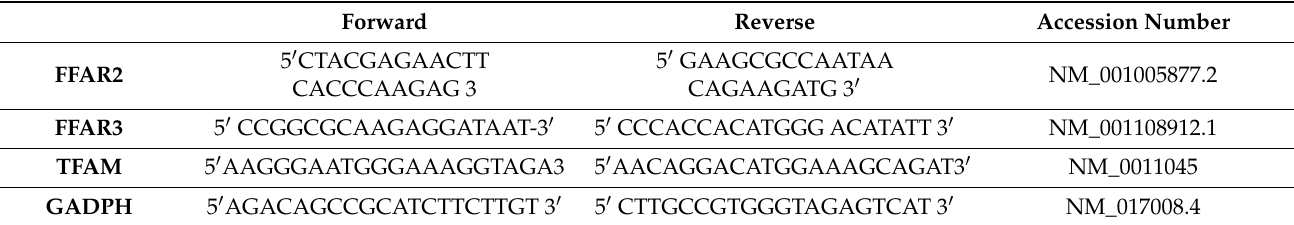
Table 6. Primers of FFAR2, FFAR3, TFAM &